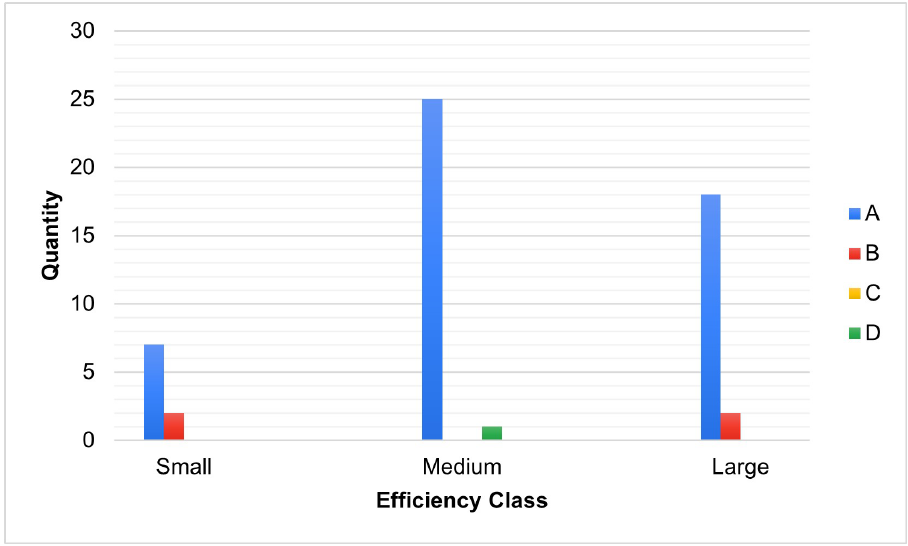
Figure 10. Efficiency Ranges of Residential Refrigerators categorized as Subtropical